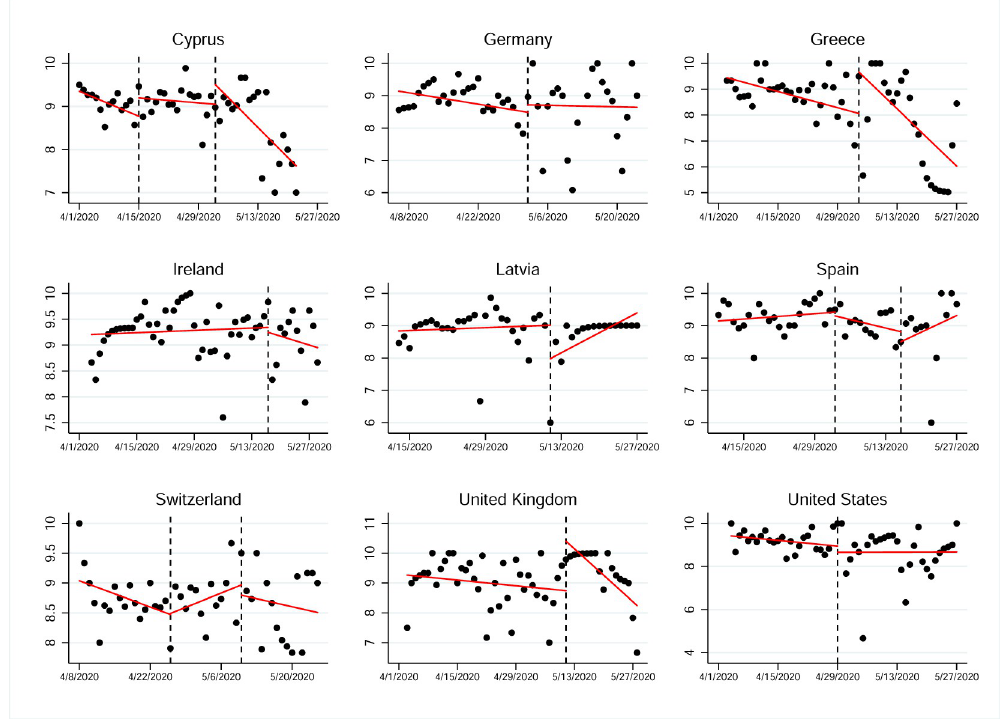
Fig 4. Interrupted time series analysis for self-protective behaviors using changes in stringency index as the intervention date (dashed horizontal line).